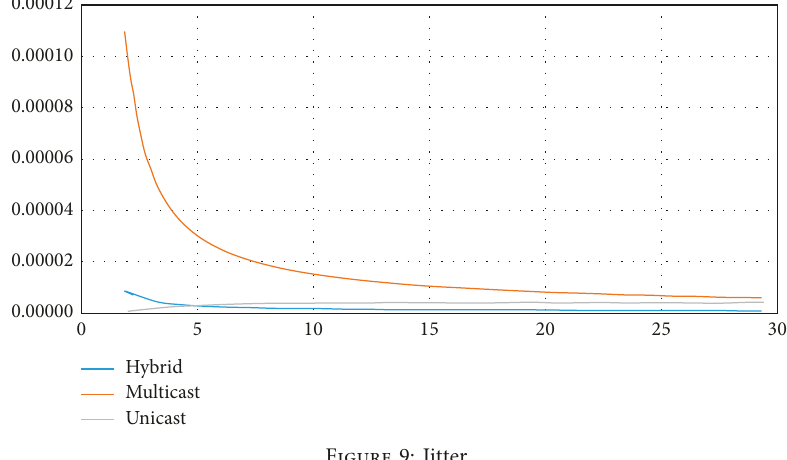
Figure 9: Jitter.